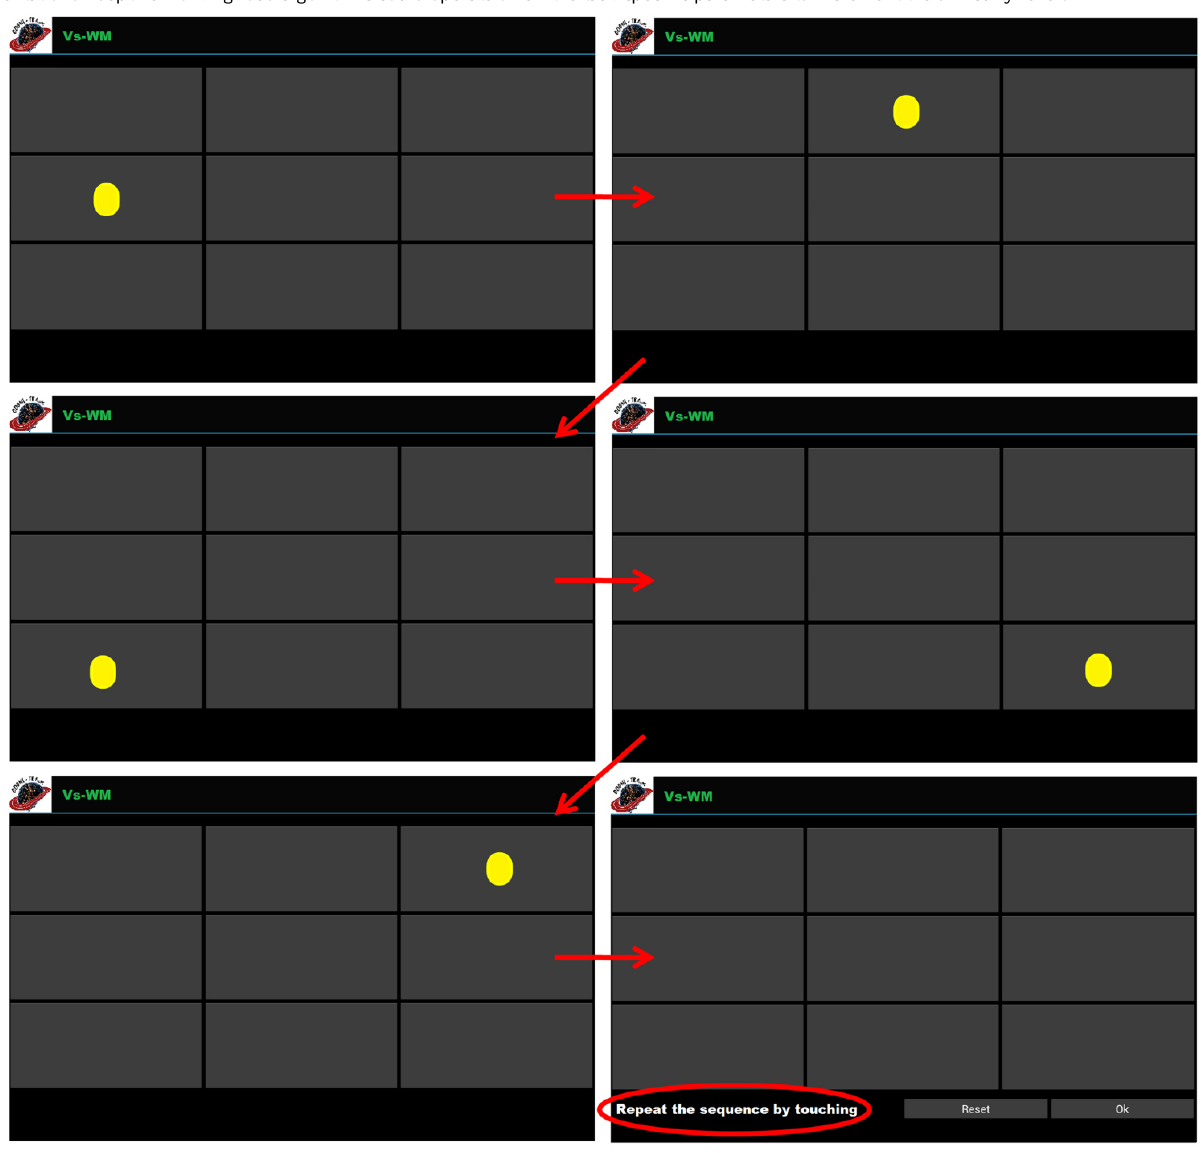
Figure 1. An example of visuospatial working memory (Vs-WM) exercises in which patients have to remember a random sequence of 5 circles consecutively presented (the temporal order is defined following the direction of the arrows). Task-specific parameters for Vs-WM include grid size (minimum 2×2; maximum not defined), number of stimuli composing the sequence (minimum 1; maximum not defined), and the rate of